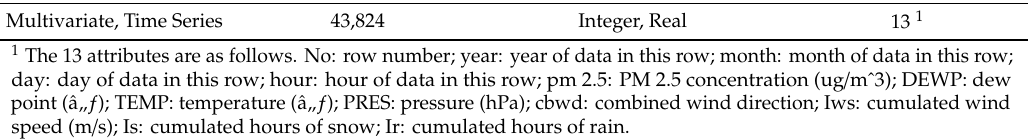
Table 5. Performance of TCN before and after structure improvement.